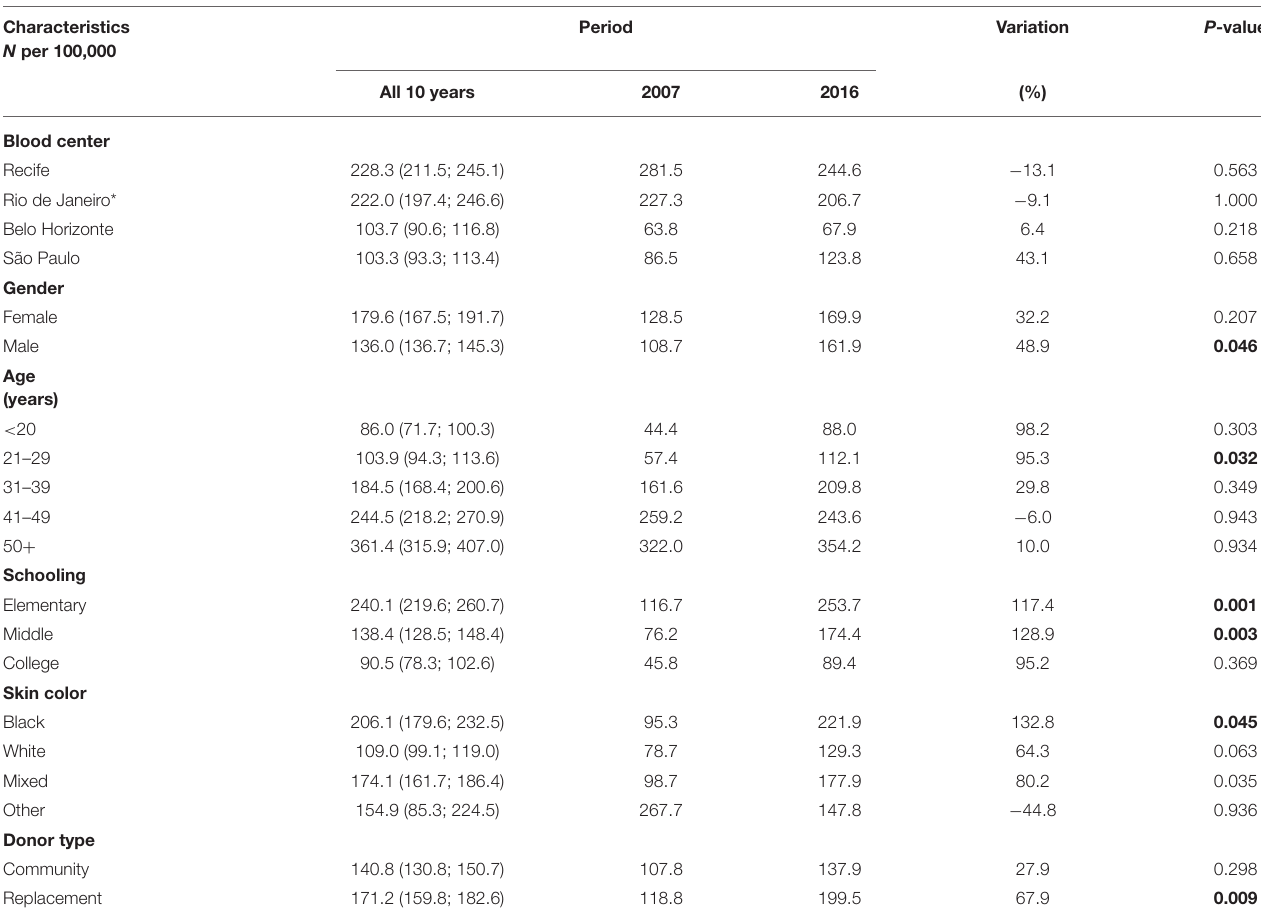
TABLE 2 | Comparative analysis of HTLV-1/2 prevalence (per 100,000) among first-time blood donors in the years 2007 and 2016 regarding gender, age groups, schooling, skin color, and type of donation. Characteristics N per 100,000